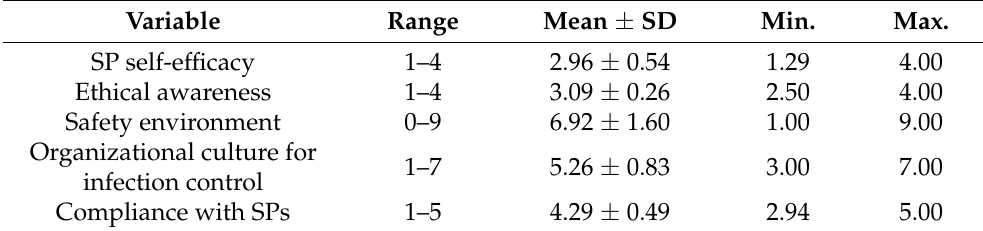
Table 2. Levels of factors related to standard precautions (N =